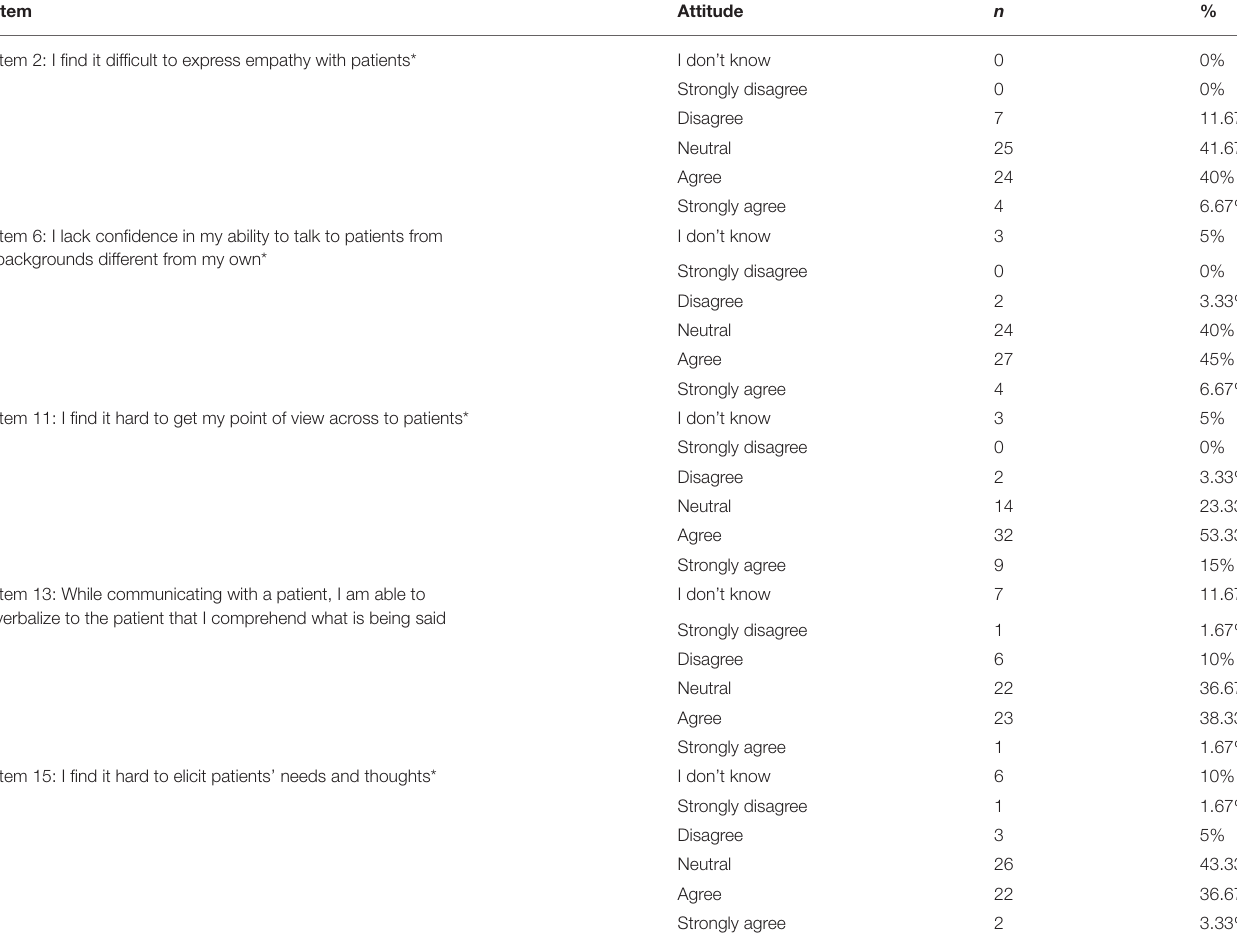
TABLE 7 | Percentages of each response for each item on perceived ability to execute engagement (Theme 2). Item Attitude n